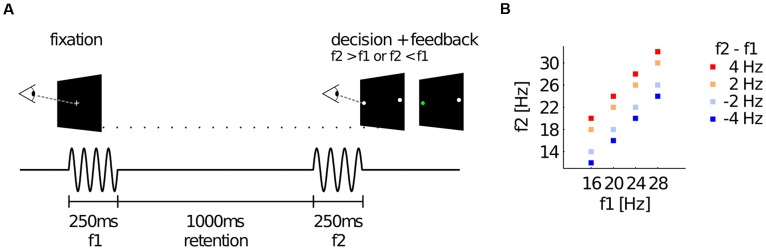
Experimental paradigm and stimulus set. (A) Illustration of a single trial. Participants were presented with two vibrotactile stimuli (with frequencies f1 and f2) at the left index finger, while holding central fixation until the offset of the second stimulus. Afterwards, they decided whether f2 > f1 or f2 < f1 by means of a horizontal saccade. Online feedback was provided immediately after the decision via color change of the selected dot (green for correct, red for incorrect trials). (B) The set of all possible frequency combinations of f1 and f2 that were applied in this study. Color-coded squares each indicate one stimulus pair with according f1 and f2 values.